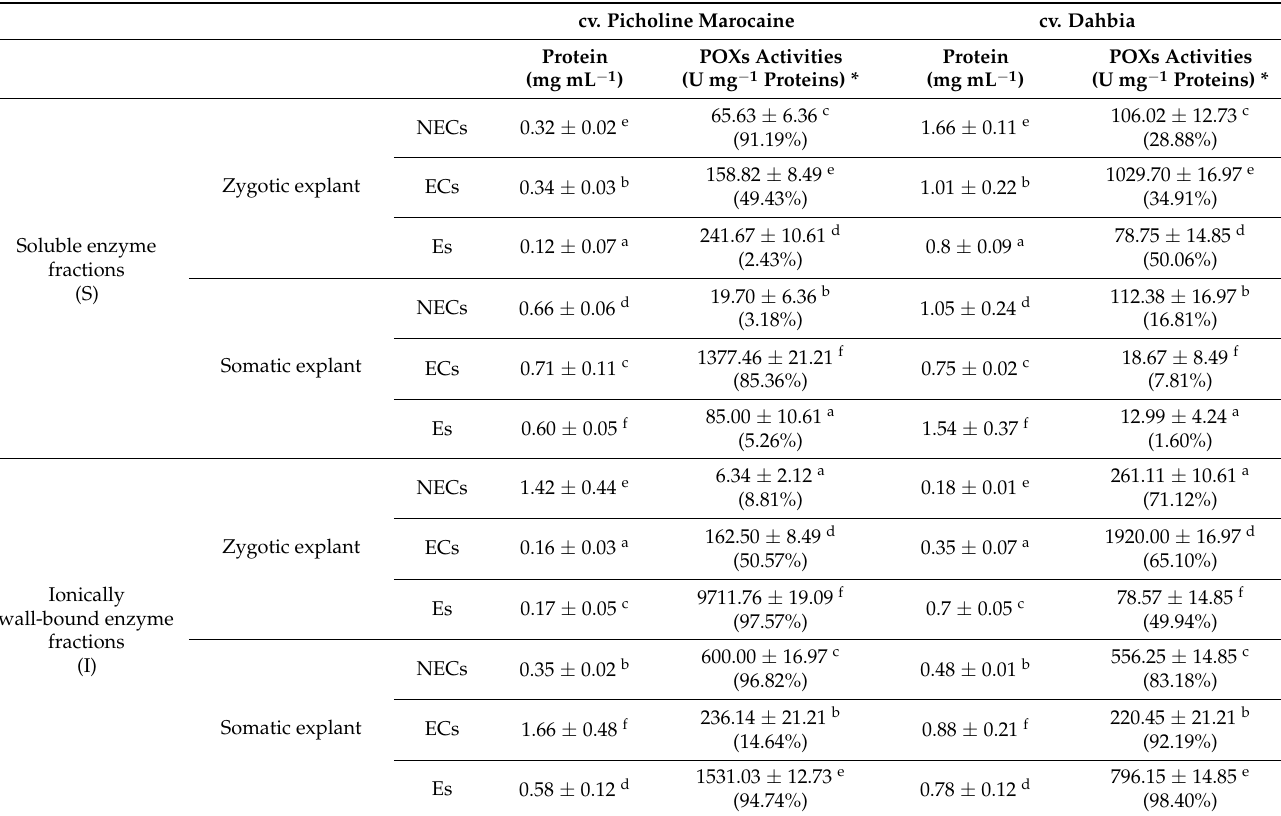
Table 2. Protein concentrations (mg mL − 1 ) and peroxidases (POXs) activities (U mg − 1 proteins) tested in soluble and ionically wall-bound enzyme fractions extracted from the nonembryogenic calluses (NECs), embryogenic calluses (ECs), and somatic embryos (Es) derived from the zygotic and somatic explants of the olive cvs. Picholine Marocaine and Dahbia.